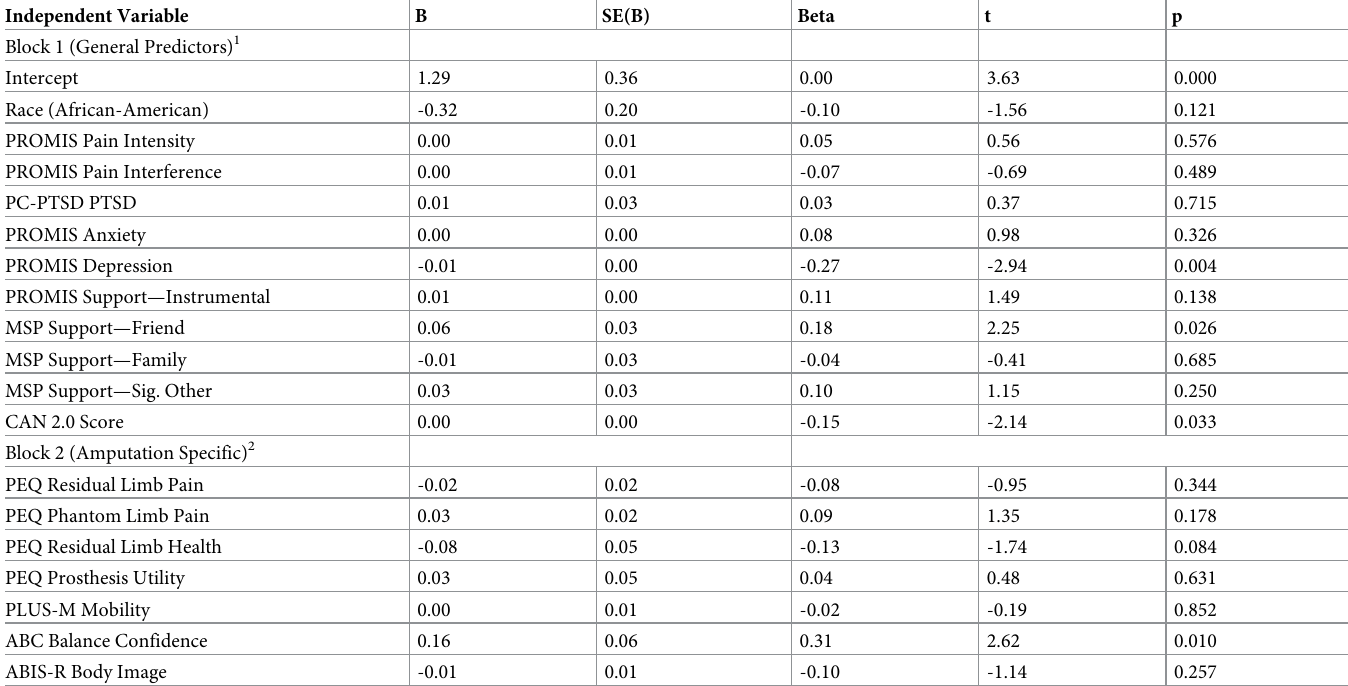
Table 6. Regression of CPI frequency on general and specific indicators. Independent